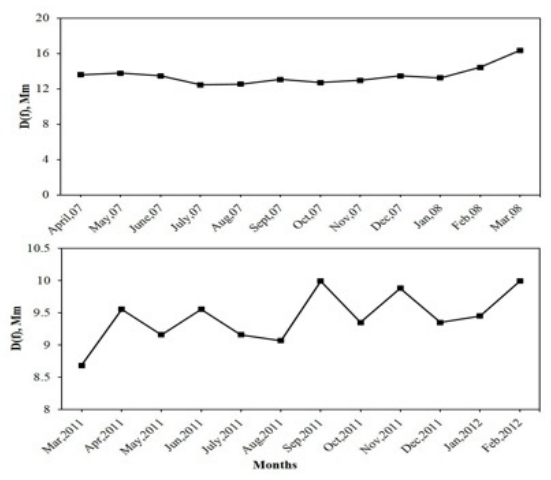
Figure 4(b). Seasonal variation of source-observer distance derived from observed first mode frequency for the two periods.